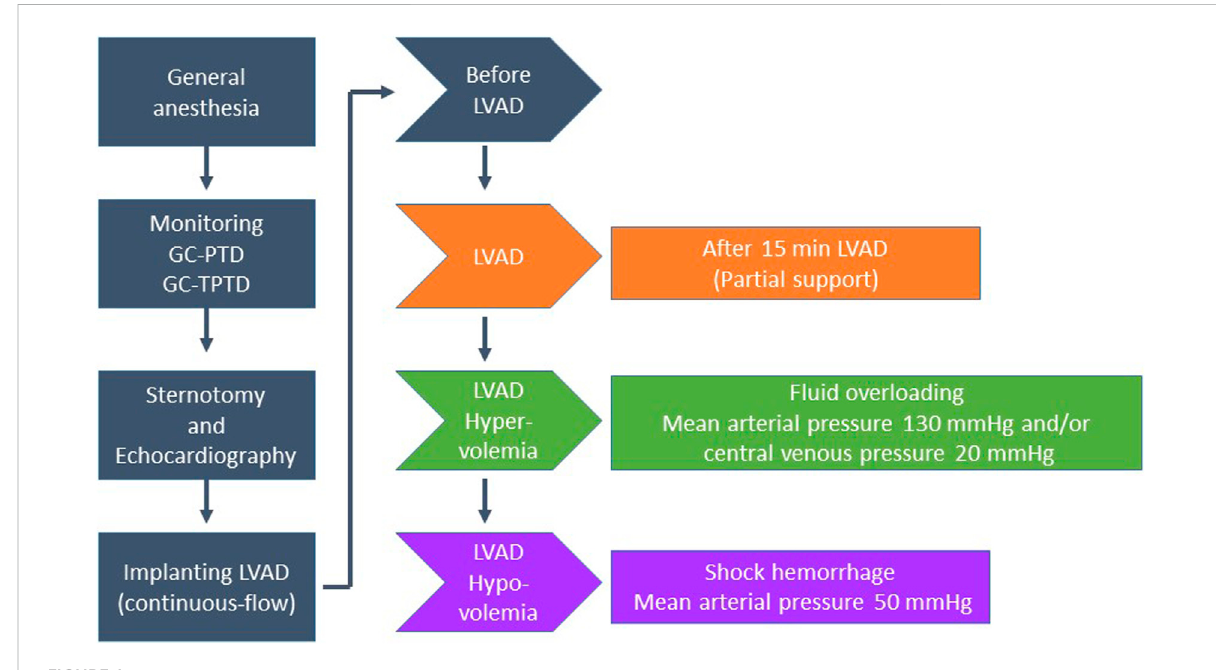
FIGURE 1 Study design (experimental procedure). Left ventricular assist devices